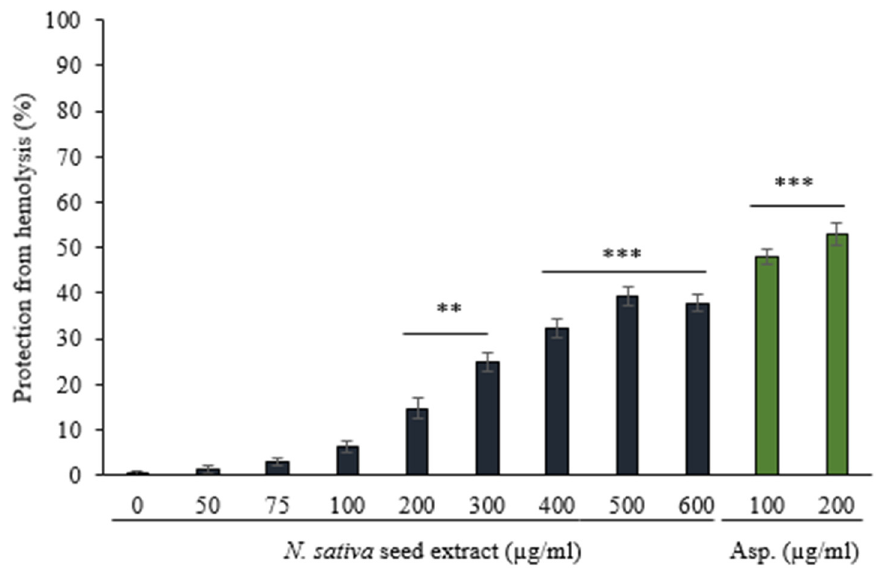
Figure 3. Effect of N. sativa seed extract on heat induced hemolysis. Aspirin was used as the positive control. The results are presented as means ± SEM ( n = 3, p < 0.05). The statistical analysis was performed by using ANOVA (** p ≤ 0.01, *** p ≤ 0.001).